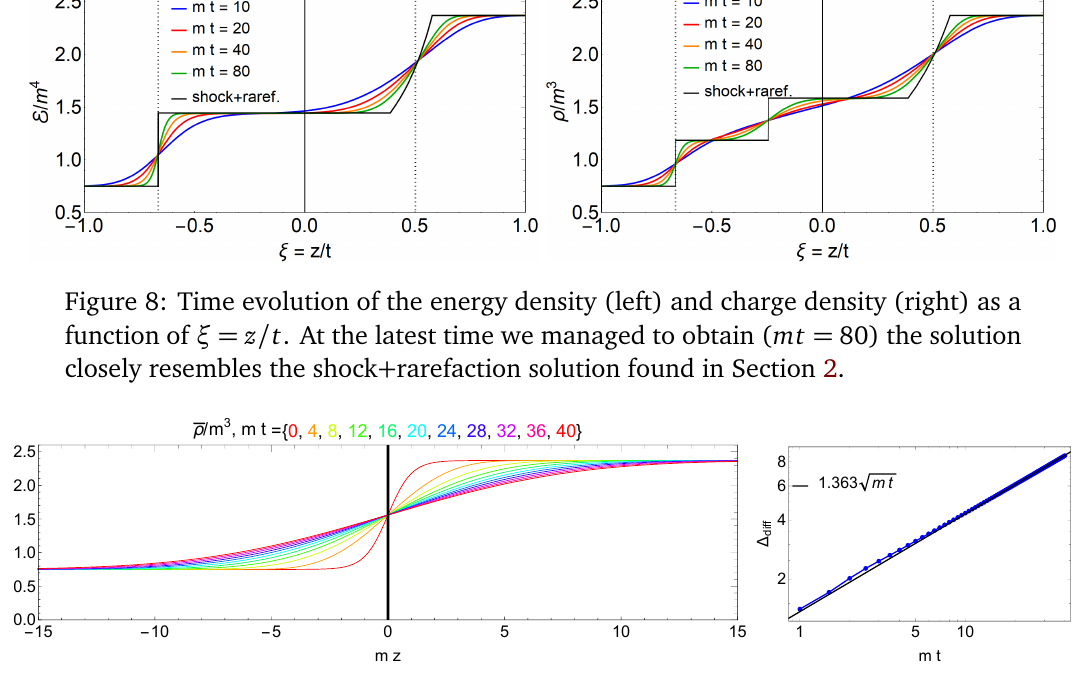
( t ) . The blue line is the diff